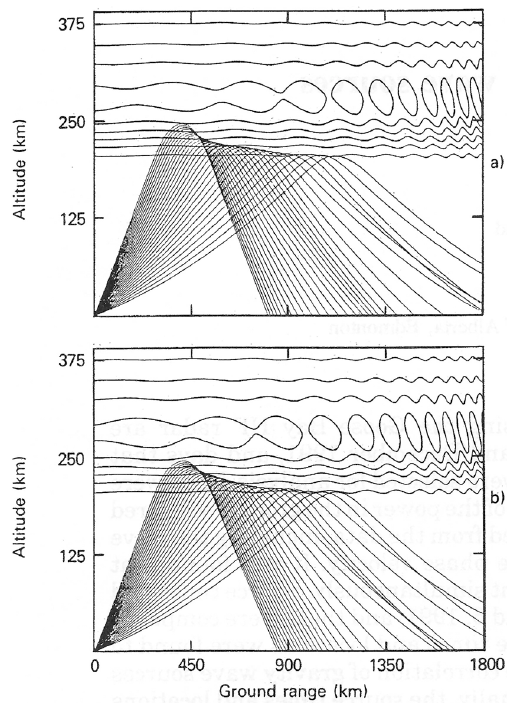
Figure 14. Ray-tracing analysis of radio wave propagation through an ionosphere impacted by an Earth-reflected gravity wave. The cor- rugated electron density surfaces on the bottom of the ionosphere affect the propagation of transmissions from an obliquely directed HF radar. Where the surfaces are concave relative to a ground ob- server, the ray paths are altered by reflection and tend to converge as they approach the Earth’s surface, leading to stronger backscat- tered signals. In contrast, rays that are incident on convex surfaces in the bottomside ionosphere are dispersed upon reflection, lead- ing to weaker forward power and weaker backscatter. Panel (a) in this figure shows the backscatter distribution 195min after the gravity wave was generated. Bunches of incoming rays are ob- served at ground ranges of 1300 and 1800km. Panel (b) shows the backscatter distribution at 210min after gravity wave excita- tion. The bunches of incoming rays have moved toward the radar- to-ground ranges of 1100 and 1600km. Reproduced from Fig. 2 of Samson et al.